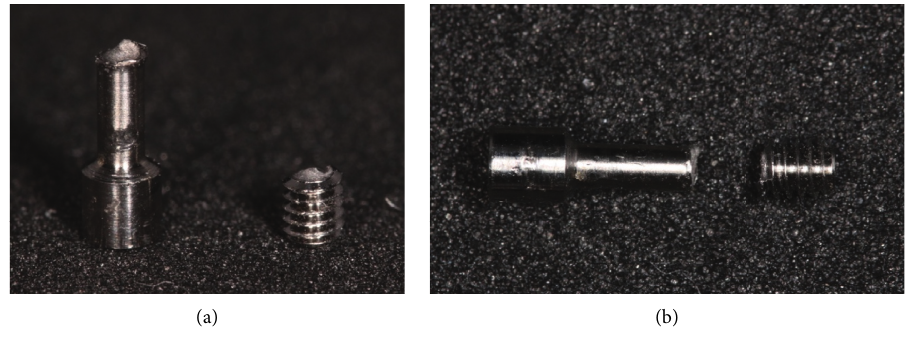
Figure 9: (a), (b) Fracture pattern of Exaktus ®